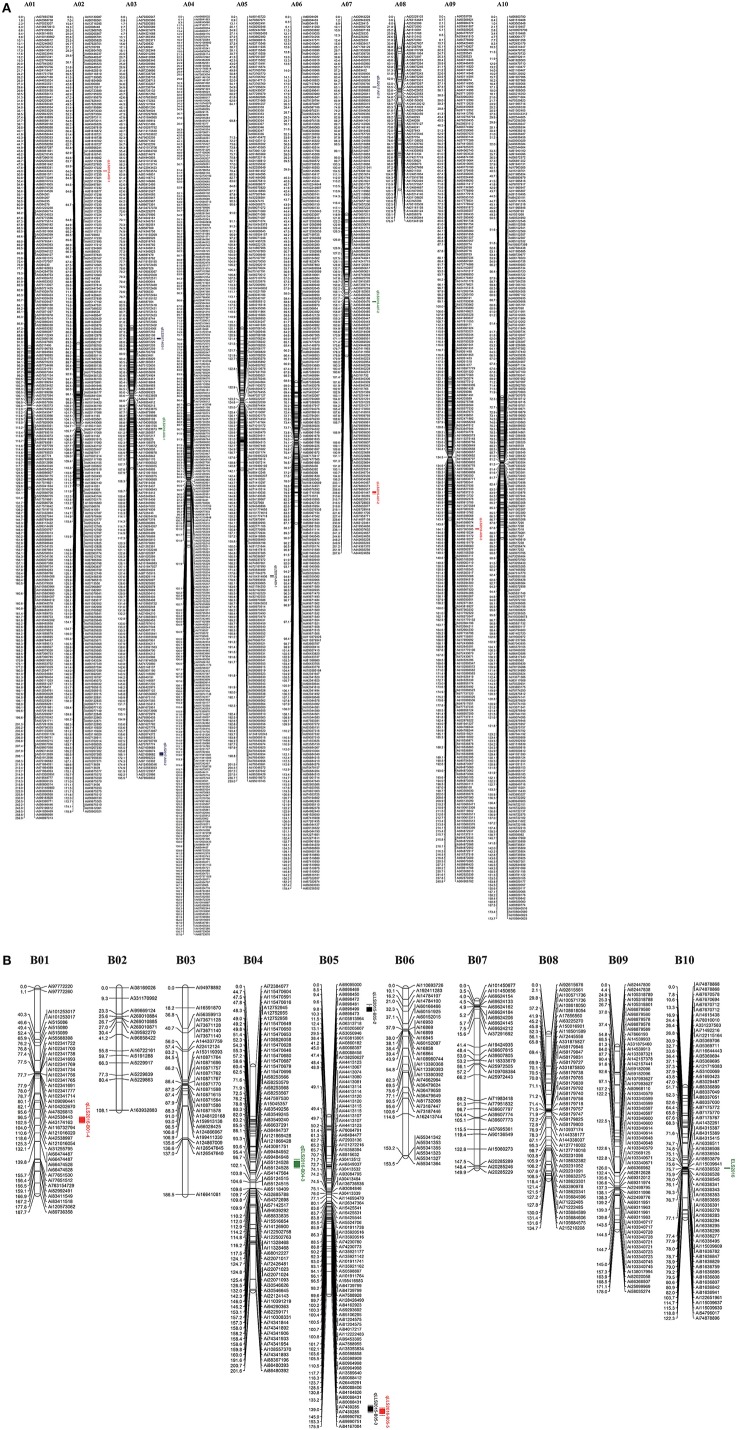
Genetic linkage map of the F9 RIL population derived from the cross of Florida 07 and GP-NC WS 16. Left of each group is map distance (cM) and right is the name of marker with physical distance (bp). (A) A genome map with 9 QTLs for resistance to early and late leaf spot diseases; (B) six QTLs for resistance to early and late leaf sport diseases identified in the B genome map.